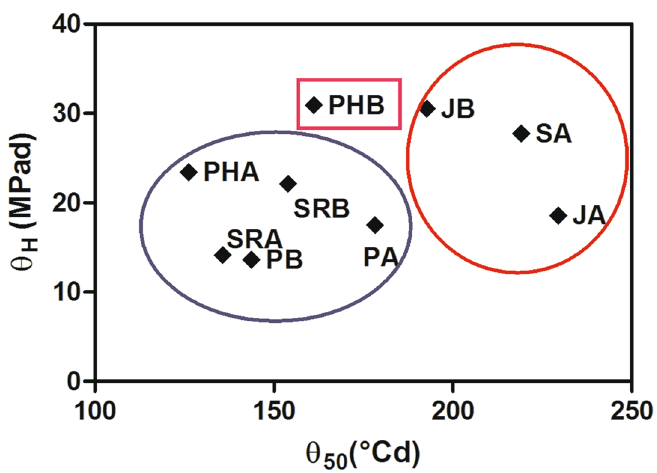
Figure 3. Relation between the thermal time (θ 50 [°C d) calculated in a previous work 37 ) and the hydrotime (θ H [MPa d]), from the present